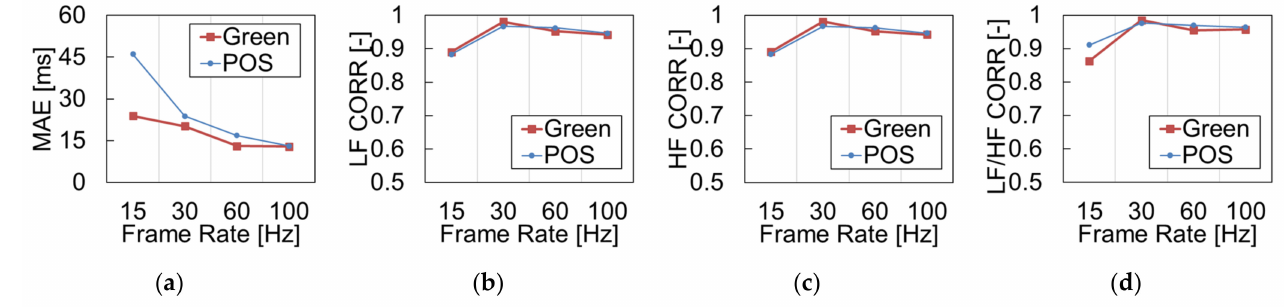
Figure 6. Performance metrics of each parameter: ( a ) RRI, ( b ) LF, ( c ) HF, and ( d )